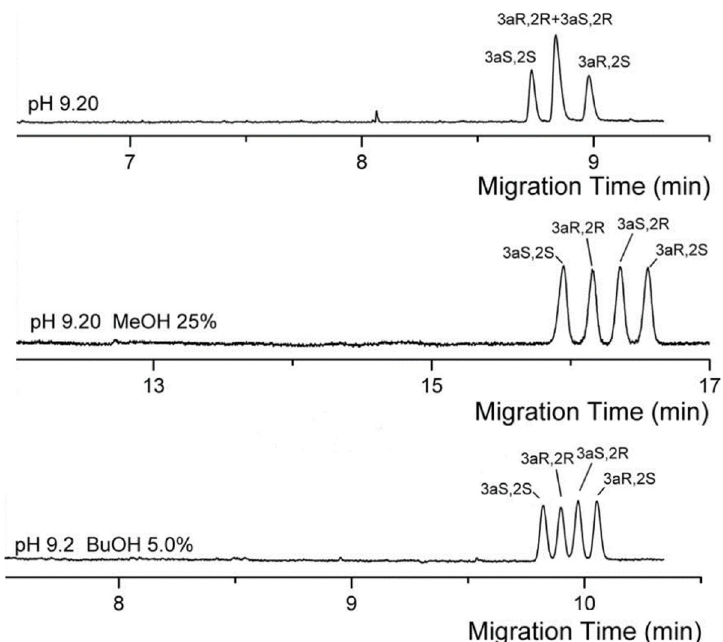
Figure 5. Electrochromatogram of the chiral separation four palonosetron hydrochloride enantiomers. Separation conditions: BGS: 70 mM sodium cholate in 30 mM sodium tetraborate (pH 9.2) with or without 25% methanol or 5% n -butanol. Sample injection: 10 kPa for 1 s. Voltage: 25 kV. Capillary temperature: 25 °C. Detection: 254 nm. Capillary dimension: 60 cm (50 cm effective length) × 50 µ m. Modified with permission from the authors [44], © 2021 John Wiley and Sons. Table 2. Chiral surfactants used in MEKC, other CS involved, conditions used, summary of outcomes, analytes tested and their corresponding references. Summary of Outcomes Analytes ref.